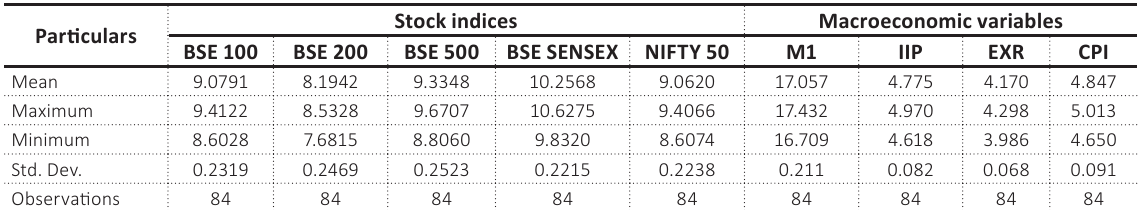
Table 2. Descriptive statistics of Indian stock indices and macroeconomic variables (natural log form):